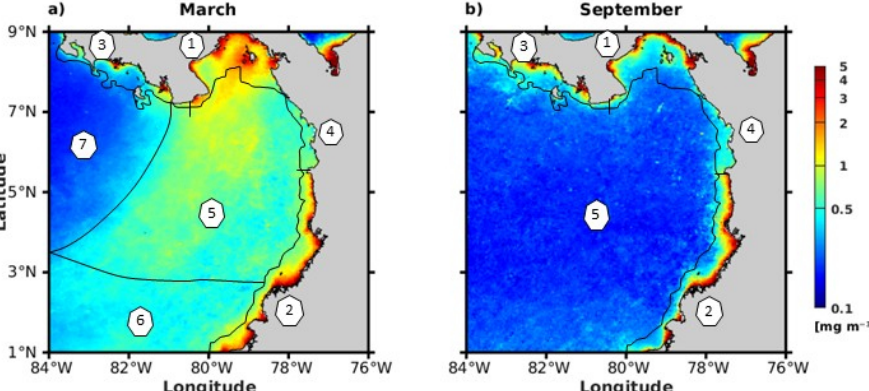
Figure 11. Climatology (2002–2016) of Chl-a (in color scale) for ( a ) March and ( b ) September. The black contours and numbers denote the areas for each subdomain.